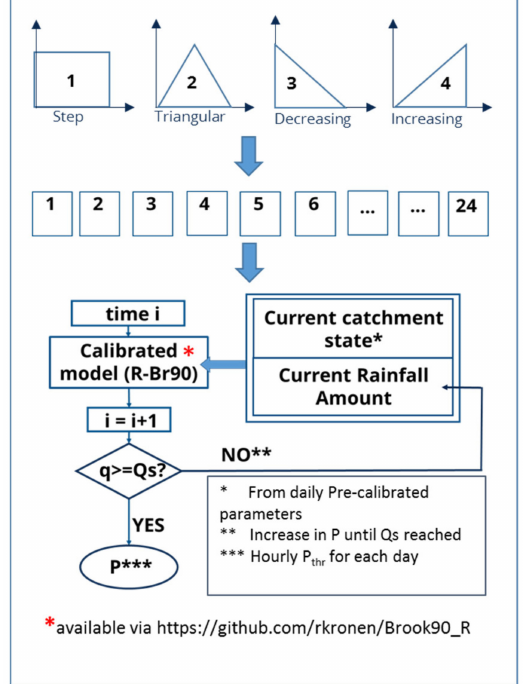
Figure 2. Different rainfall designs used as model input (hyetotypes and durations) and flow chart of inverse hydrological modelling for rainfall threshold